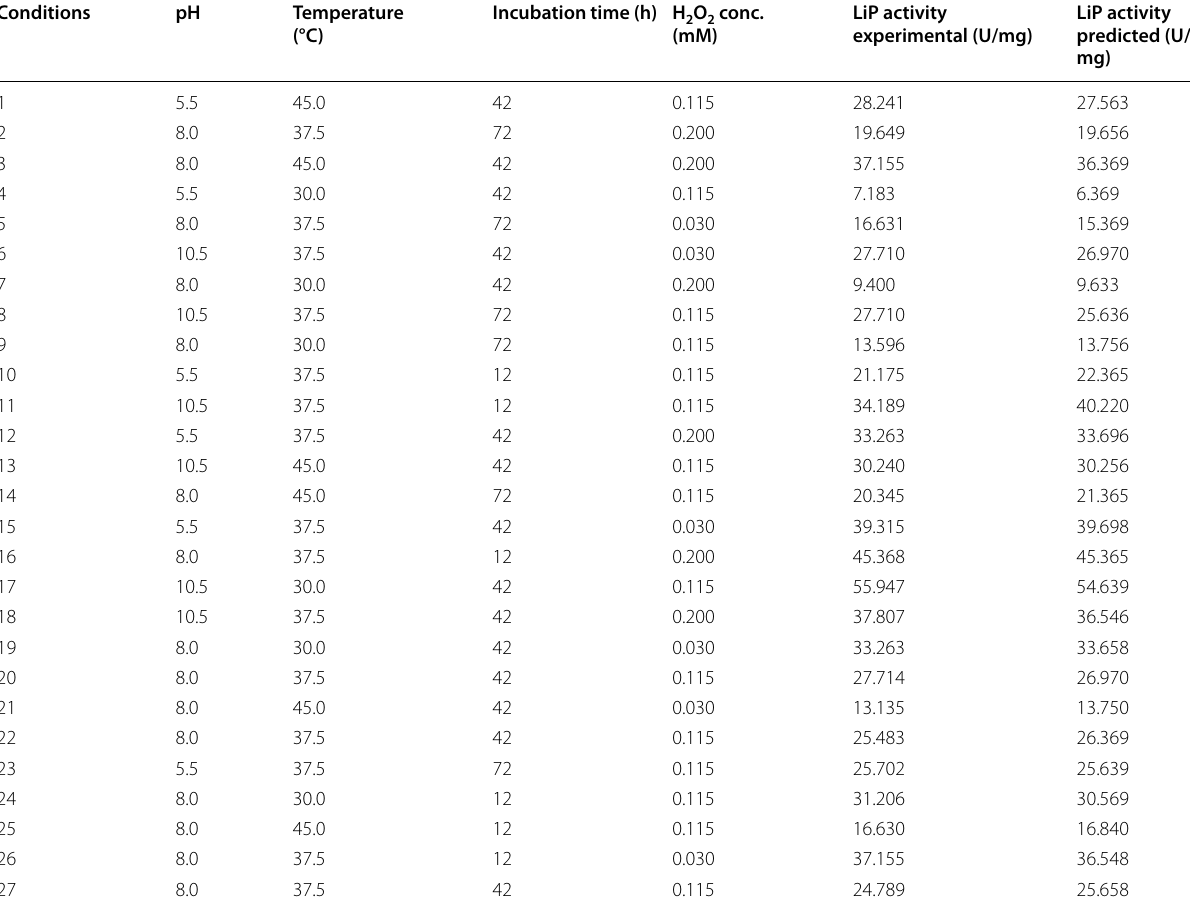
Table 2 Optimization of fermentation parameters using response surface methodology with Box-Behnken design